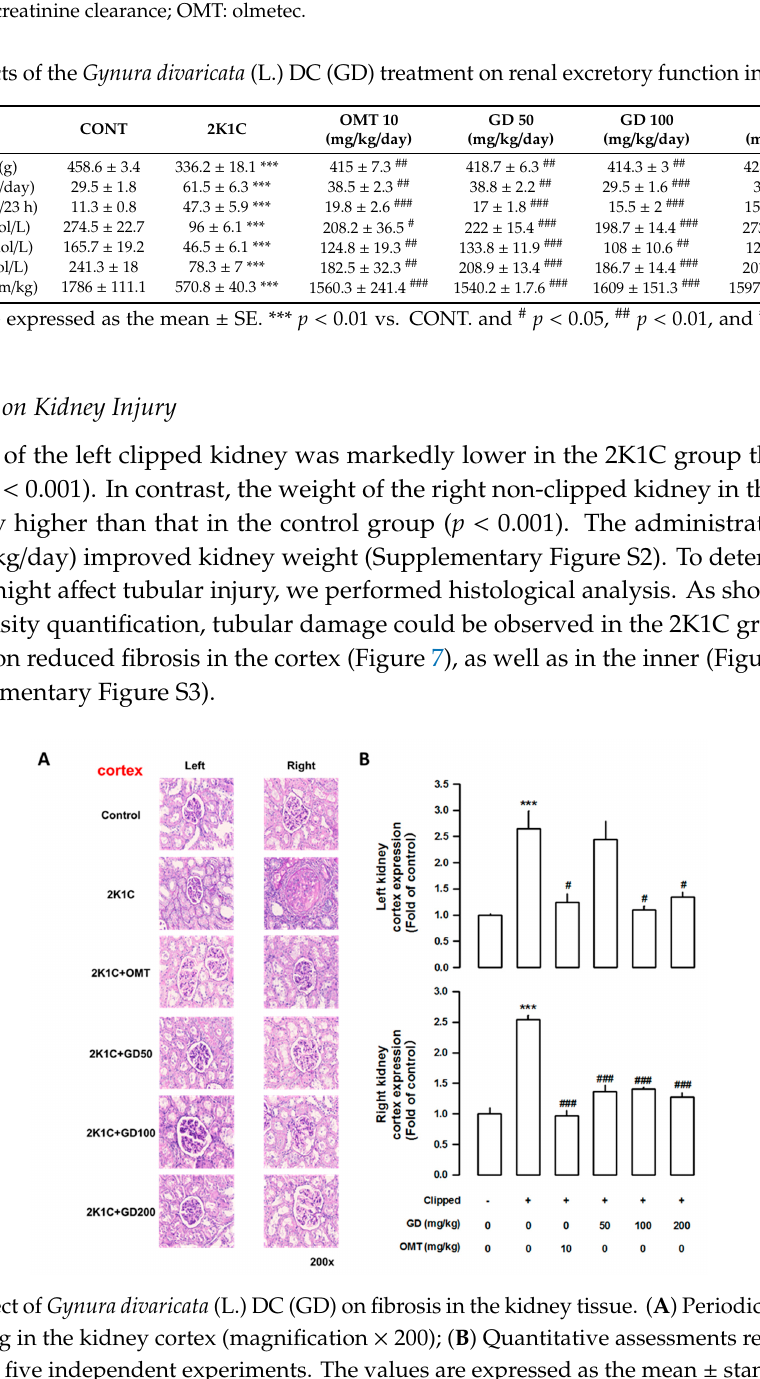
Figure 8. Effects of Gynura divaricata ( L .) DC (GD) on kidney fibrosis in the outer medulla. ( A ) Periodic acid-Schiff staining of the kidney in the outer medulla. (magnification × 200); ( B ) Quantitative